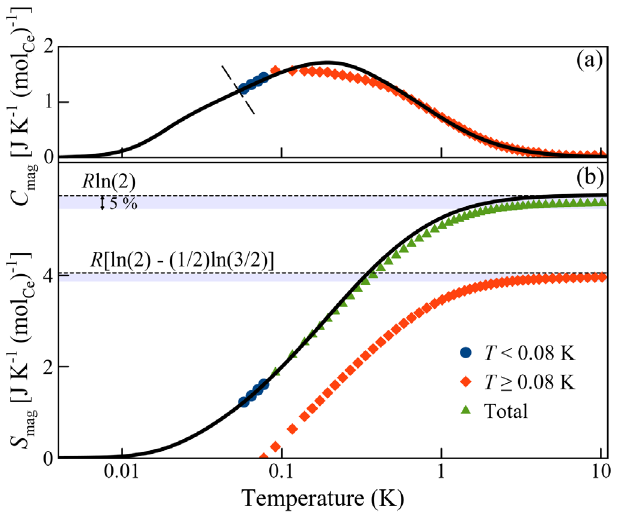
FIG. 11. (a) The measured C and best-fit C interpolation mag mag for the Ce 2 Zr 2 O 7 sample of the present work. The data are divided into high and low T regimes around T ¼ 0 . 08 K, which separates the plateau regime from the rapidly decreasing C mag regime. (b) The magnetic entropy recovered from S mag ¼ R T ð C mag =T Þ dT over the full temperature range ( T 0 ¼ 0 K) T 0 and above the onset of the plateau ( T 0 ¼ 0 . 08 K) are shown. This is derived from the integration of C shown in (a), and mag employs the C interpolation below the lowest measured mag temperature, accounting for gapless photons as well as gapped spinons and visons. R ln ð 2 Þ in entropy is recovered over the full temperature range, to within 5%, which is the approximate deficiency expected for Ce 4 þ in this sample. The Pauling spin ice entropy R ½ ln ð 2 Þ − 1 ln ð 3 is recovered from the onset of the 2 2 Þ(cid:2) plateau, T ¼ 0 . 08 K, to T ¼ 10 K to within approximately the same